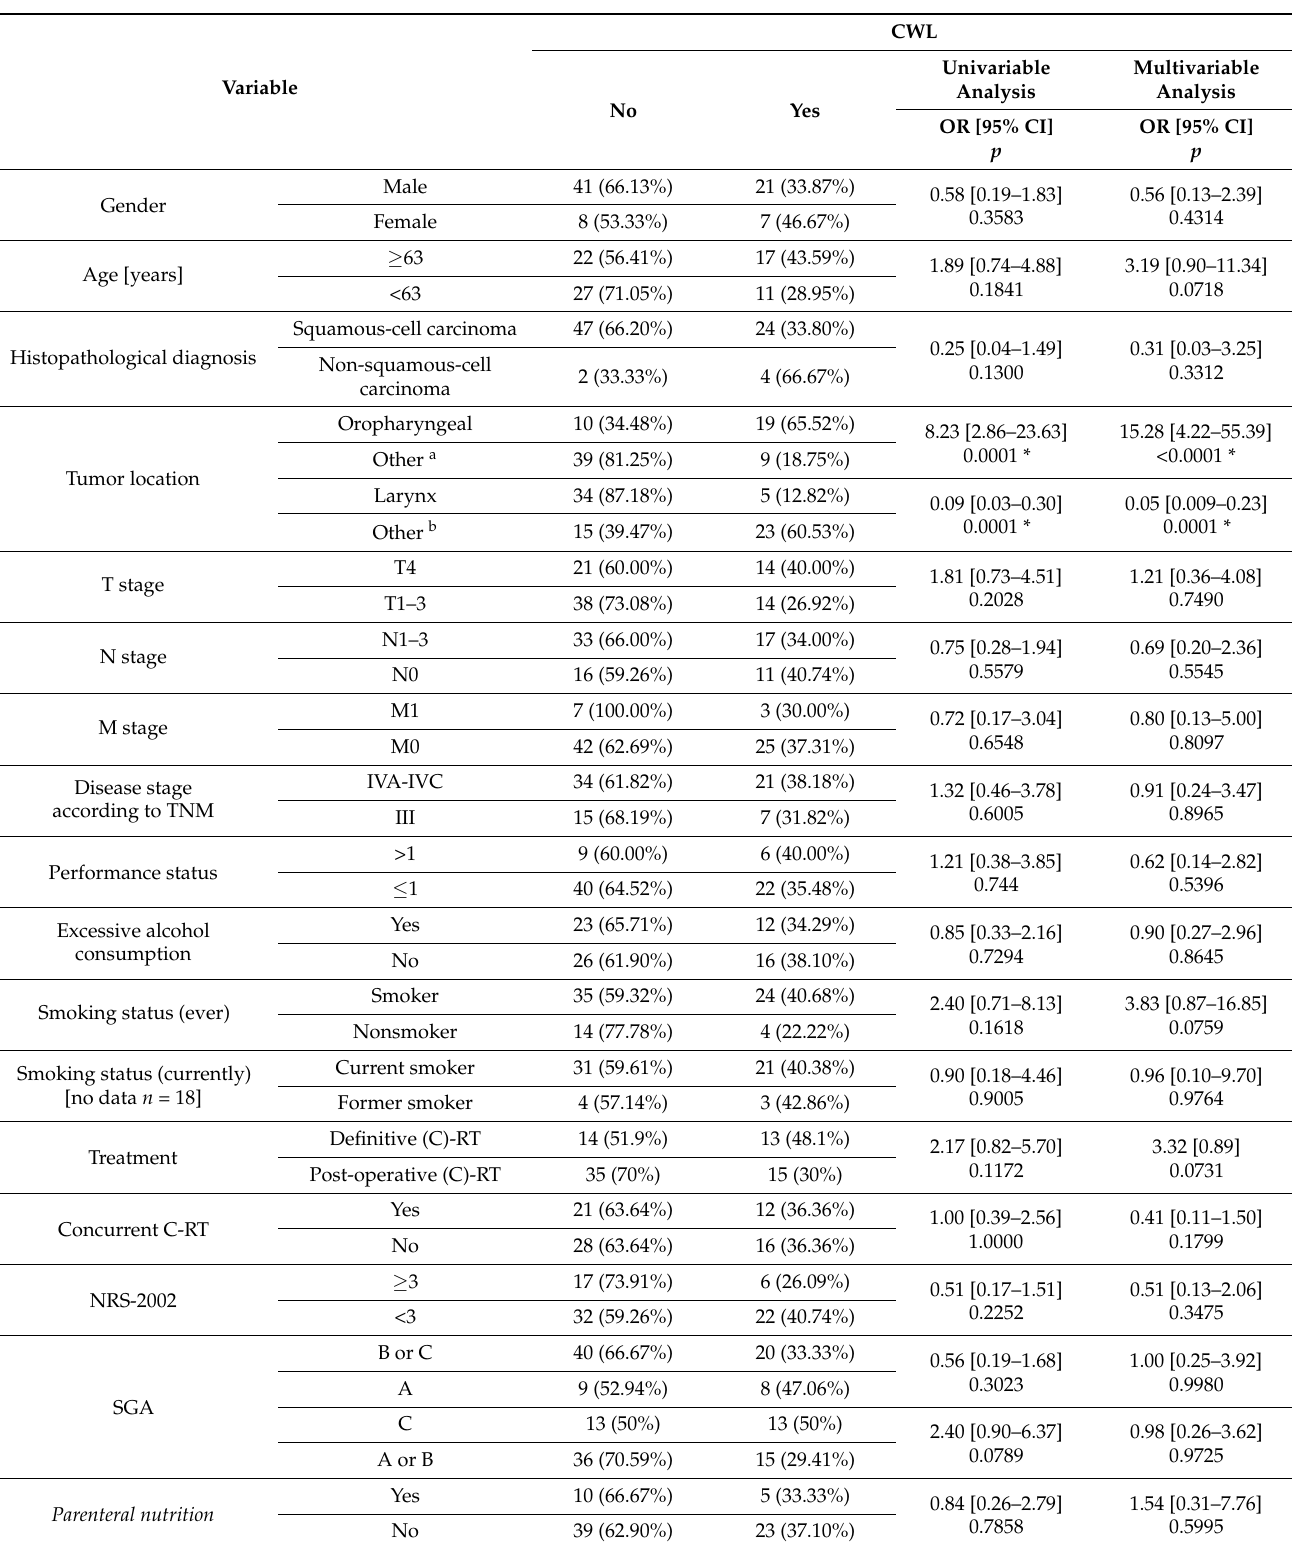
Table 5. The influence of the demographic, clinical, and genetic variables on the critical weight loss